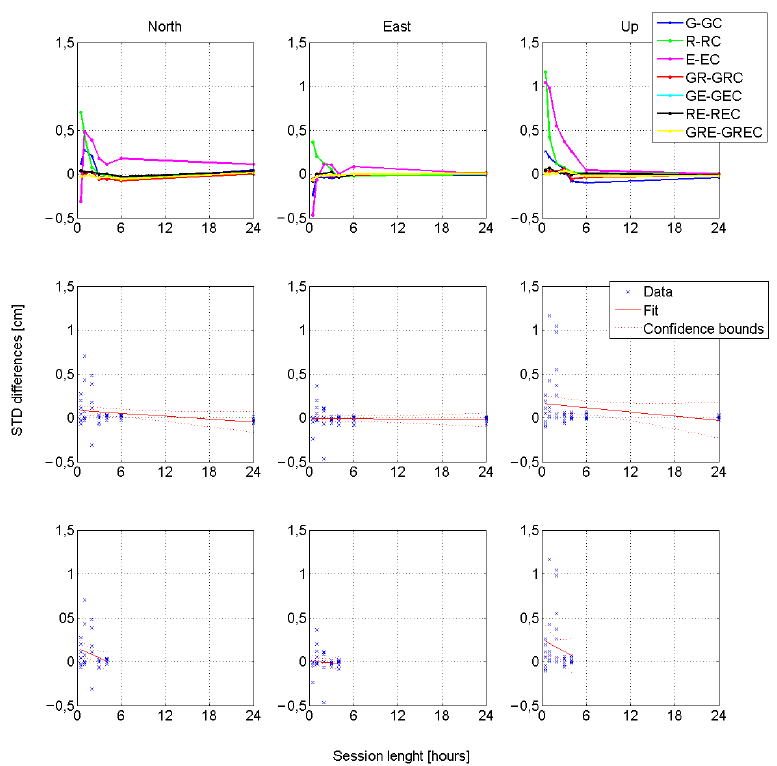
Figure 5. SD coefficient differences. Upper subpolts present results of comparison SD obtained from solution without and with BeiDou observations, central subplots present linear regression plot for up to 24 hours data; bottom subplots present linear regression plot for up to 4 hours data. Table 8. The slope regression coefficient for SD differences.